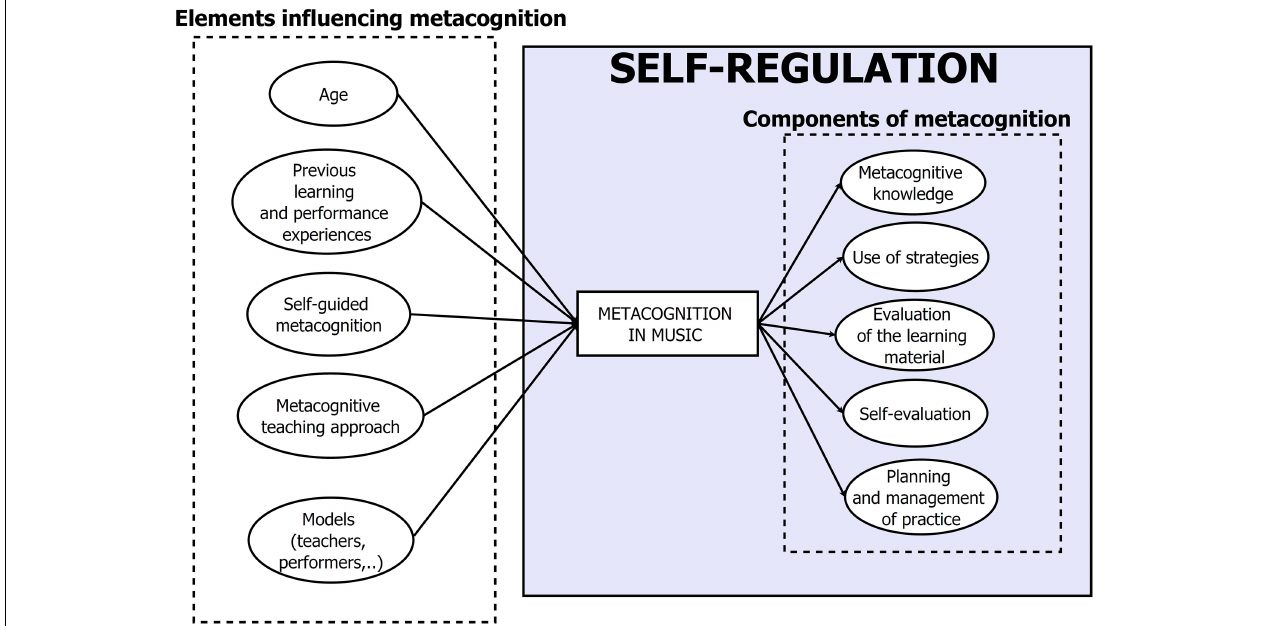
FIGURE 1 | Schematization of the main aspects affecting metacognition in music and its components.